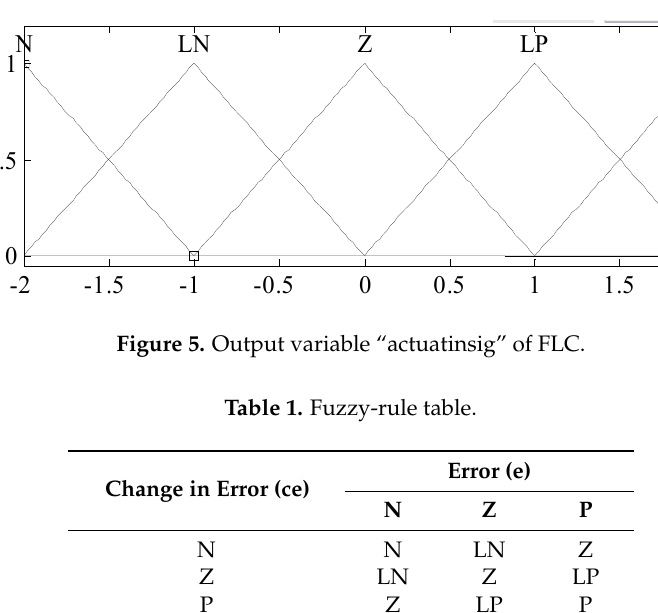
Figure 4. Inputs variables of fuzzy logic controller (FLC): ( a ) “e” and ( b ) “ce”.